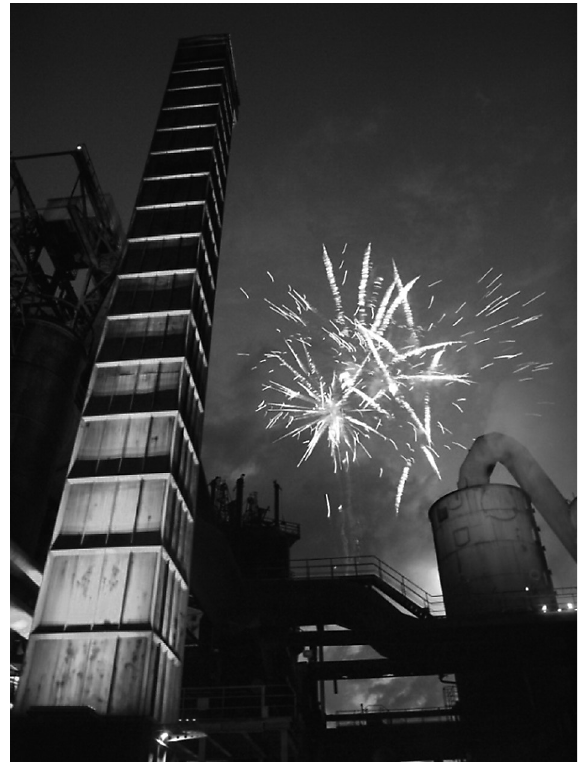
Fig. 3. Landscape Park Duisburg-Nord: a firework at the “Extraschicht” 2012 (photo by M. Otto,